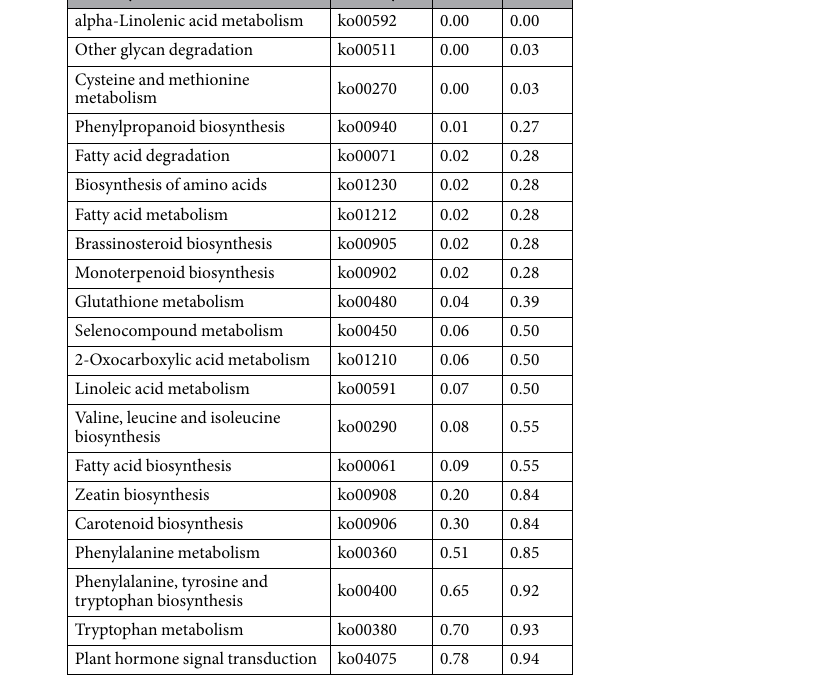
Table 3. Pathways annotated from all